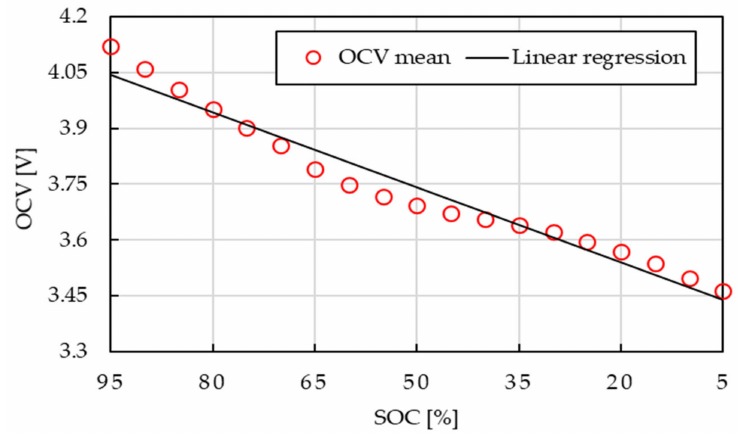
Figure 8. OCV vs. SOC characteristic.